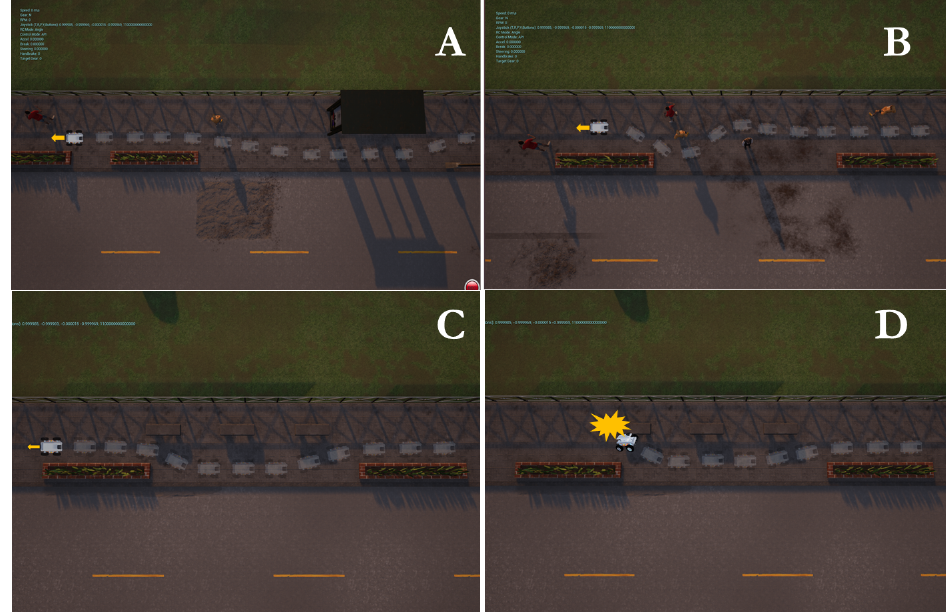
Figure 10. Different emerging behaviors during simulation experiments. At each snapshot, a long exposed trajectory is shown. ( A–C ) The robot adjusts its heading and forward velocity to avoid obstacles along the predicted trajectory using the proposed approach. ( D ) Snapshot shows where the robot crashed using the DWA algorithm.